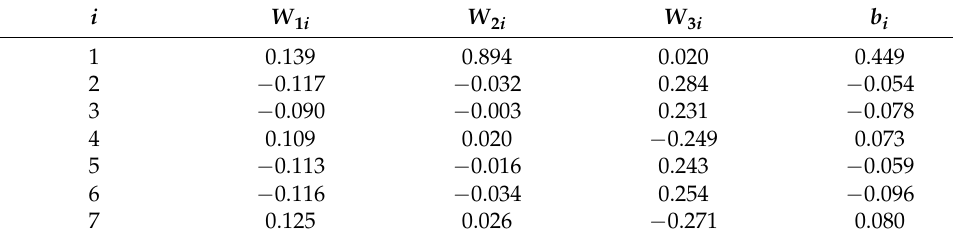
Table 7. Weight and bias values between input and hidden layer for